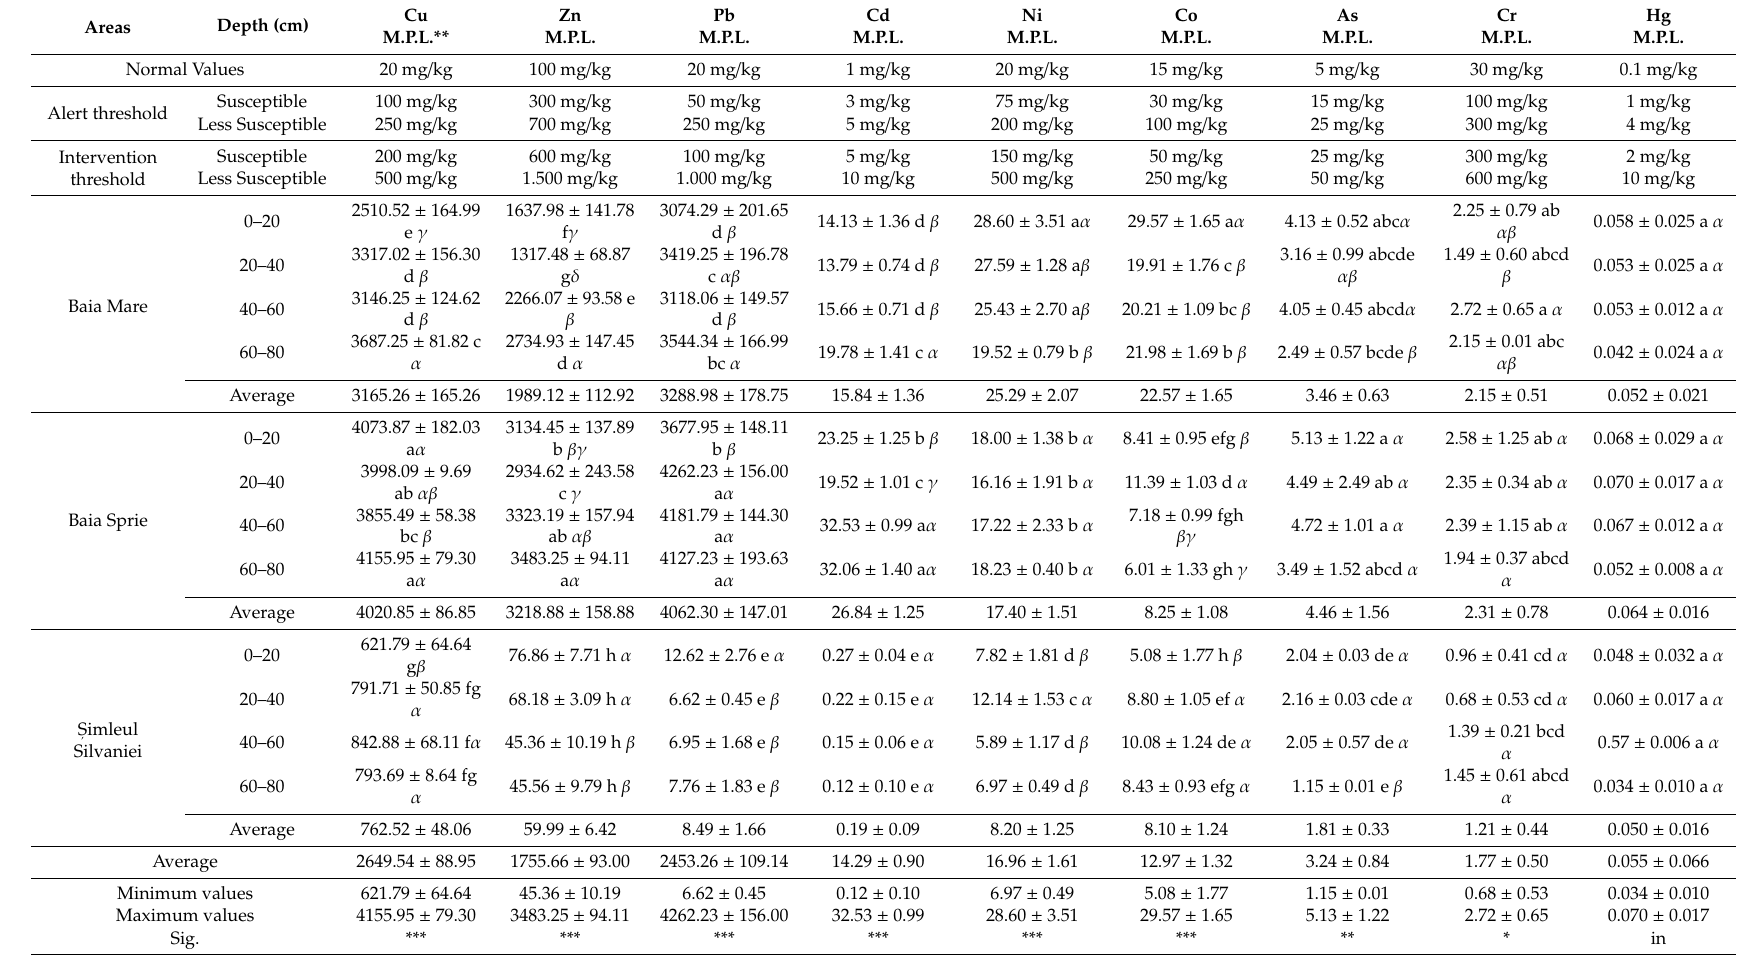
Table 1. The content of heavy metals in soil from areas studied (mg / kg DW) (Mean ± standard deviation) ( n =